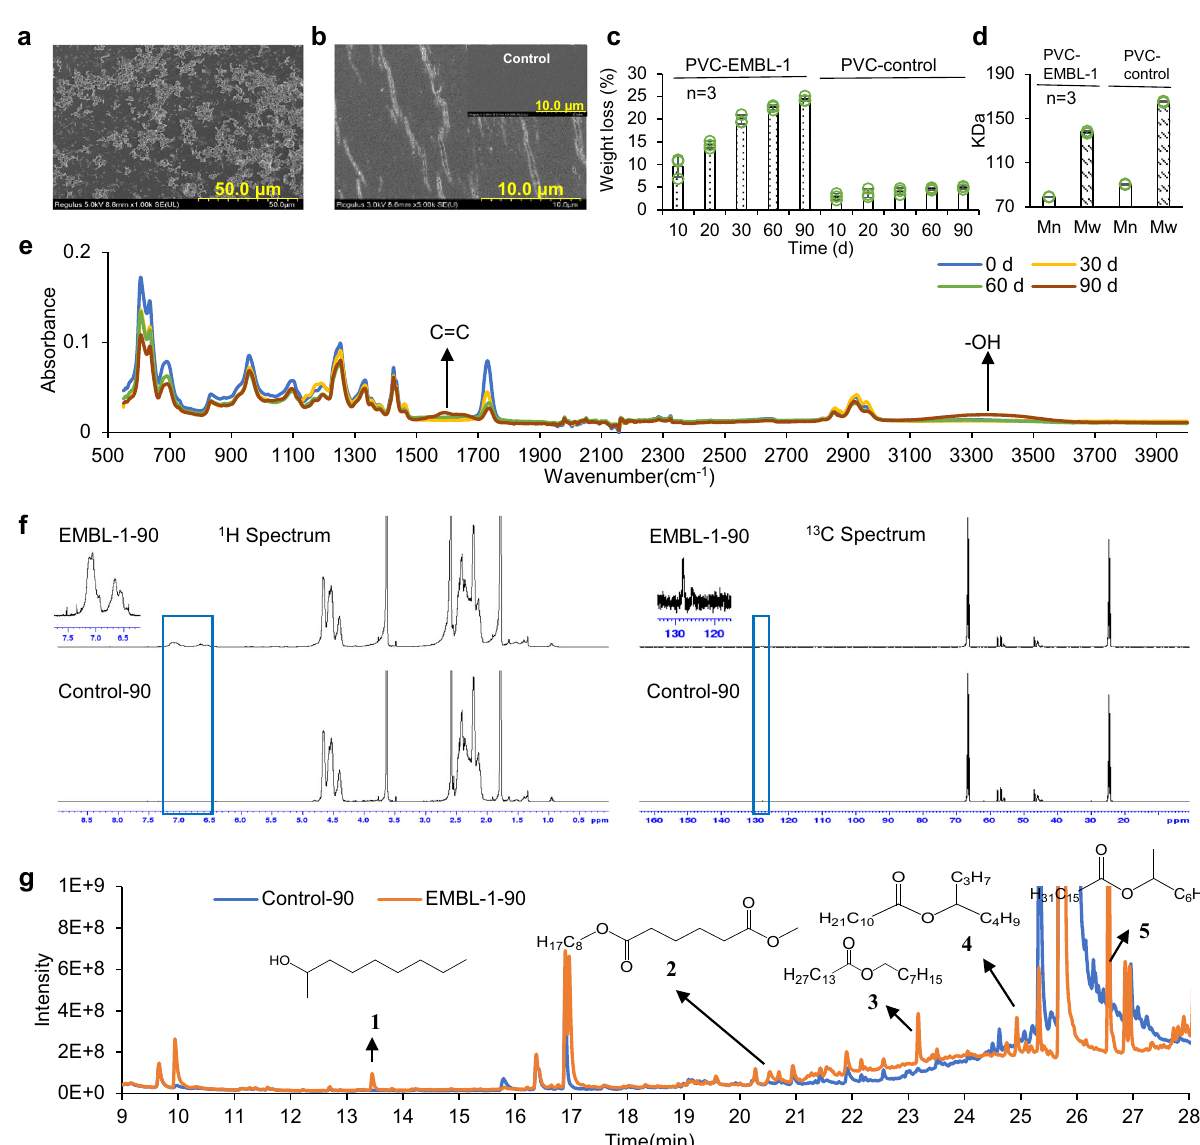
Fig. 2 | Physicochemical characterization of PVC fi lm degradation by strain EMBL-1.a TheSEMimageofthebio fi lmformedbystrainEMBL-1onPVC fi lmatday 10. b SEMimageofthecracksformedbystrainEMBL-1onthePVC fi lmatday10and the insert image in panel b was the PVC fi lm in the control group. c , d The weight loss ( c ) and molecular weight ( d ) of PVC fi lm in PVC-EMBL-1 group (strain EMBL-1 added)andPVCcontrolgroup(nostrain)during90days.Eachexperimentalgroup wasconductedintriplicate,themeanvalues(±standarddeviation)werevisualized,